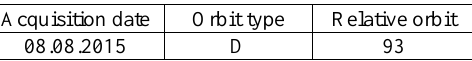
Figure 4. Zimnicea Harbour – 02.08.2015 - Sentinel-1A